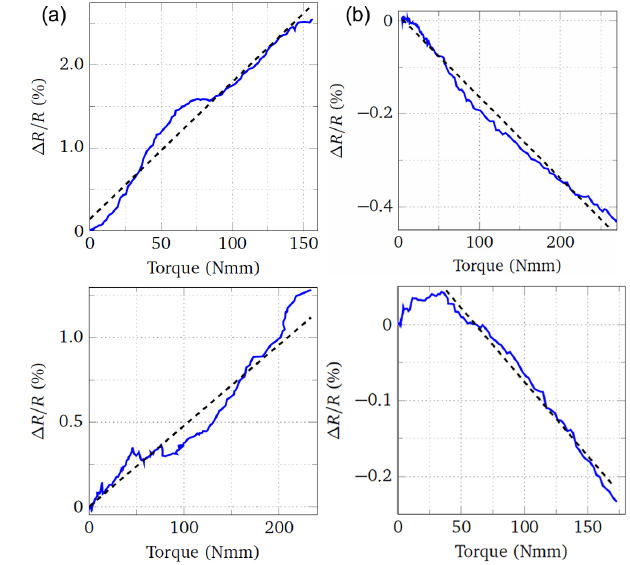
Figure 9. Relative change in resistance versus torque applied to ABS Flex (a) and HTM140M (b) screws during the fastening phase.